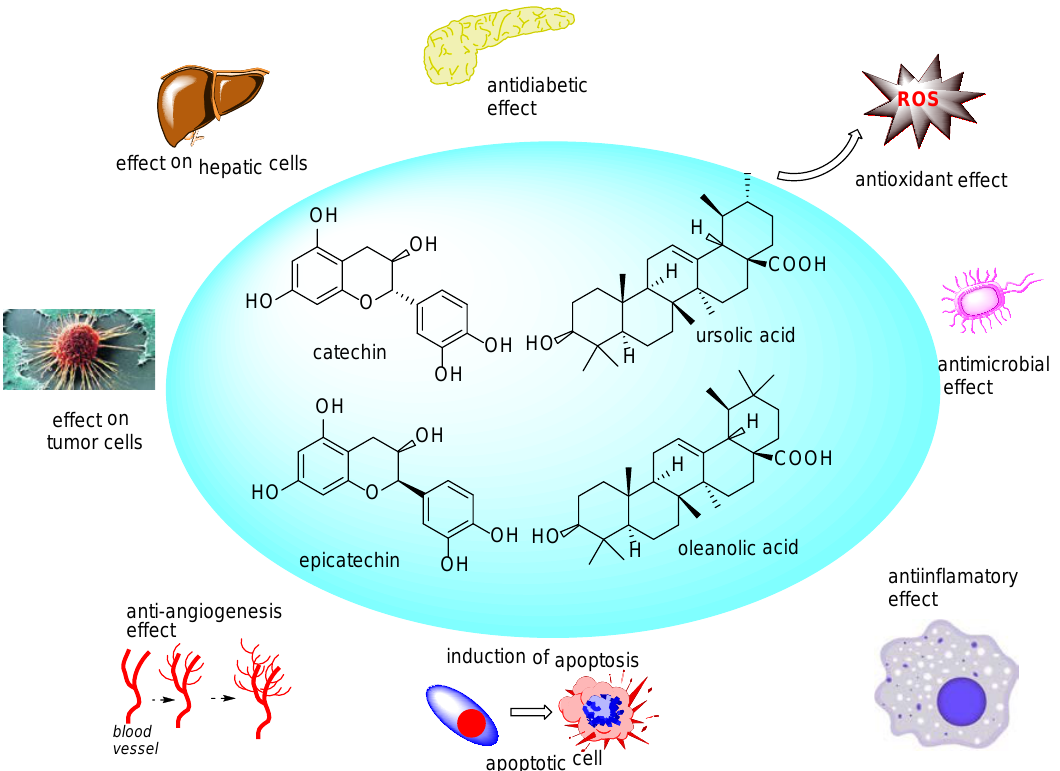
Figure 9. Main components of analy zed Cucurbitaceae juices and their biologic activities .